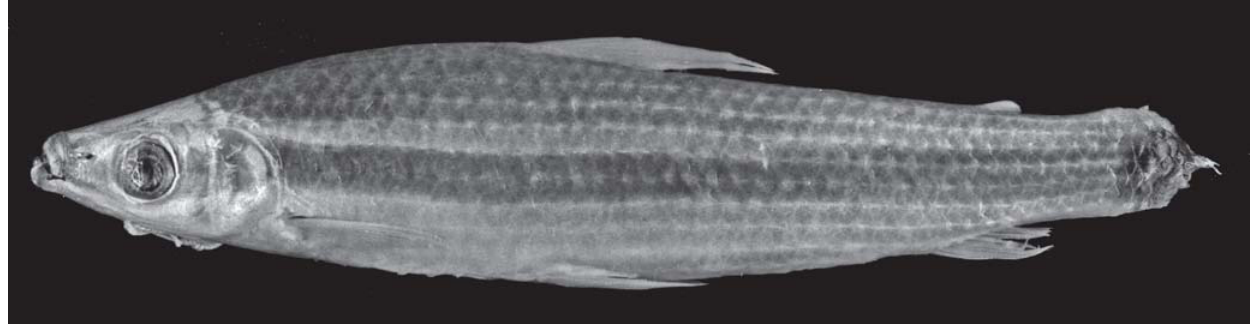
Fig. 12. Laemolyta garmani , holotype, MCZ 19370, 160.6 mm SL; Brazil, Amazonas, Silva, lago Saracá. Caudal fin entirely damaged and lacking in the